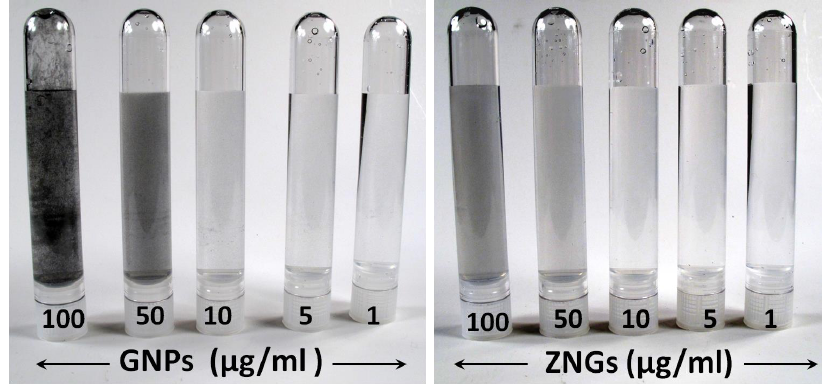
Figure 5. Photographs of GNPs and ZNGs aqueous suspensions prepared at various concentrations.